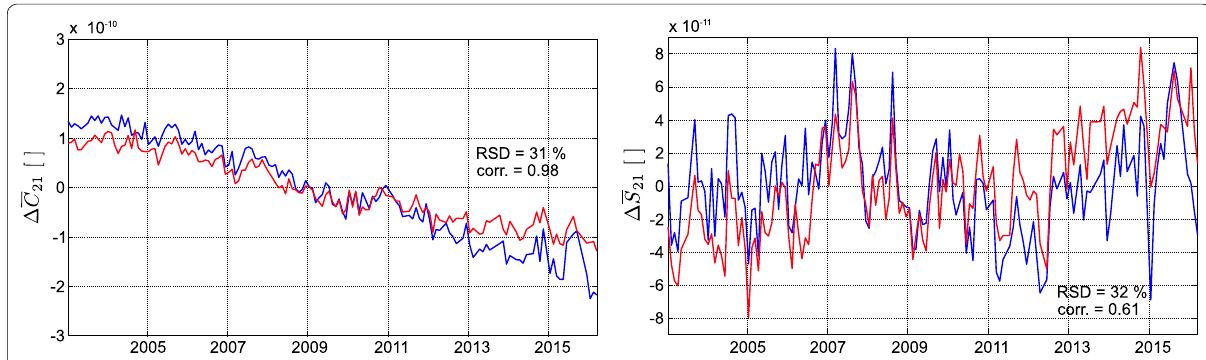
Fig. 1 Comparison of the CSR RL05 (blue) and CSR RL06 (red) solutions for the normalized spherical harmonic potential coefficients (cid:31) ¯ C 21 and (cid:31) ¯ S 21 (mean values of the time series are removed). The corresponding correlation coefficient and relative standard deviation (RSD) are